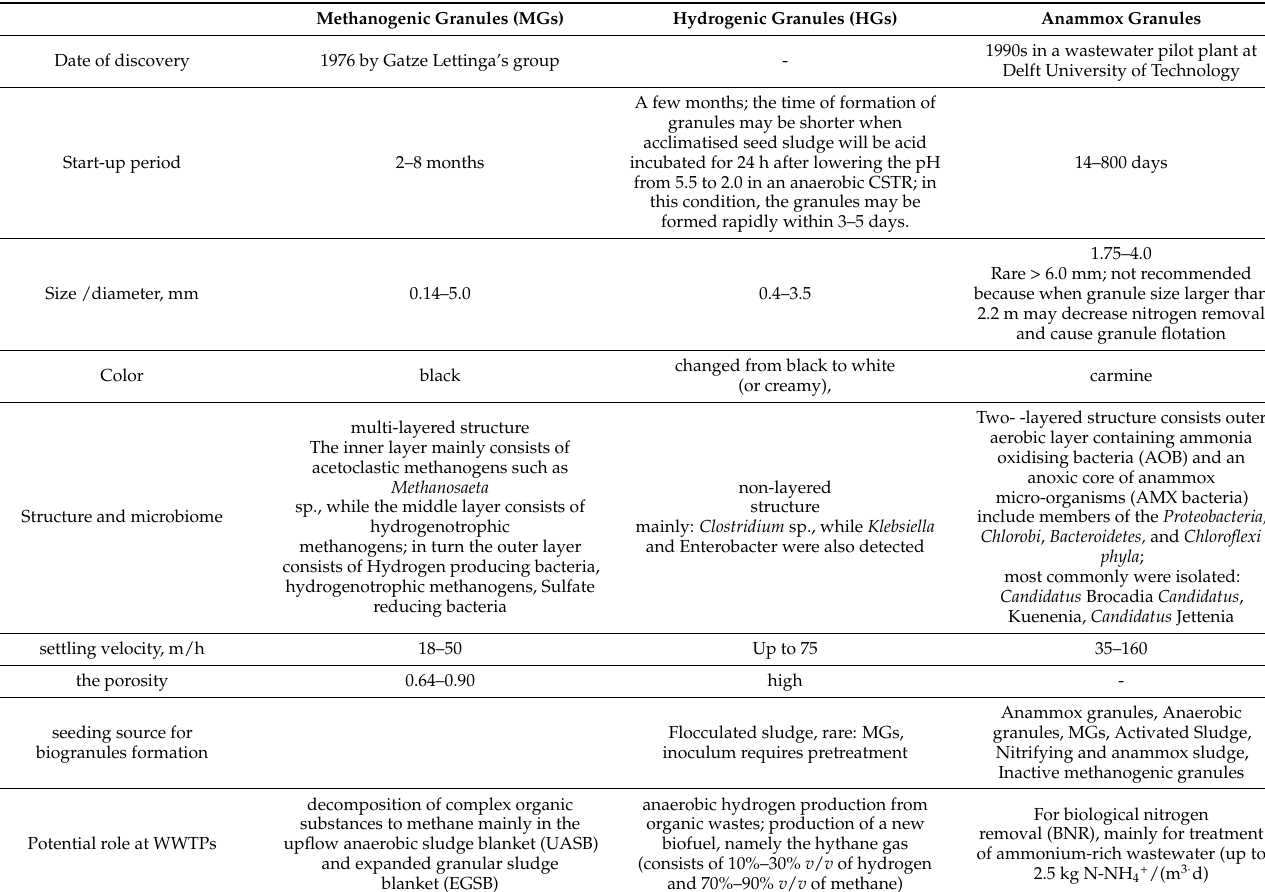
Table 1. Comparison of various types of anaerobic biogranules